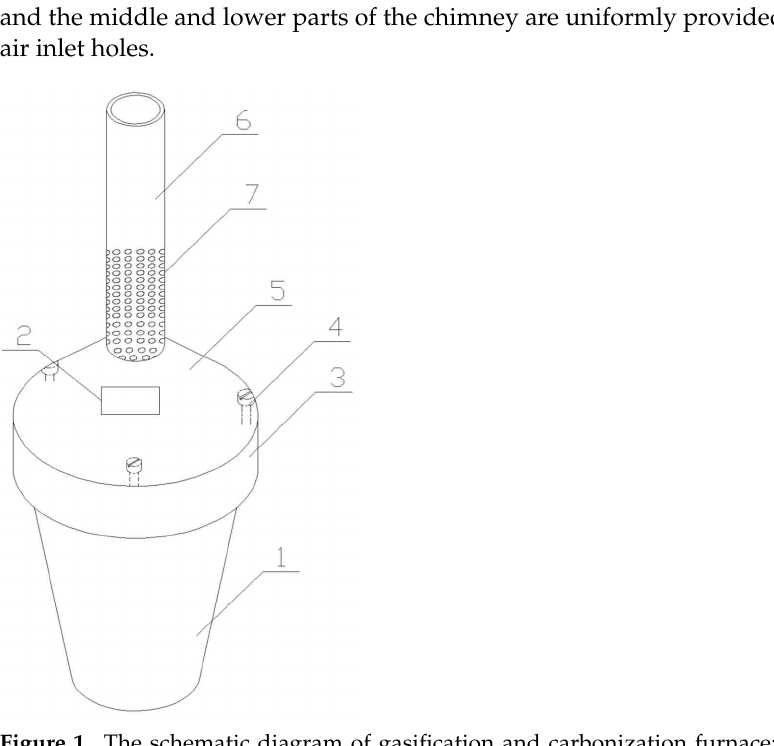
Figure 1. The schematic diagram of gasification and carbonization furnace: 1. furnace body; 2. ignition port; 3. fend; 4. adjusting bolt; 5. furnace cover; 6. chimney; 7. air inlet